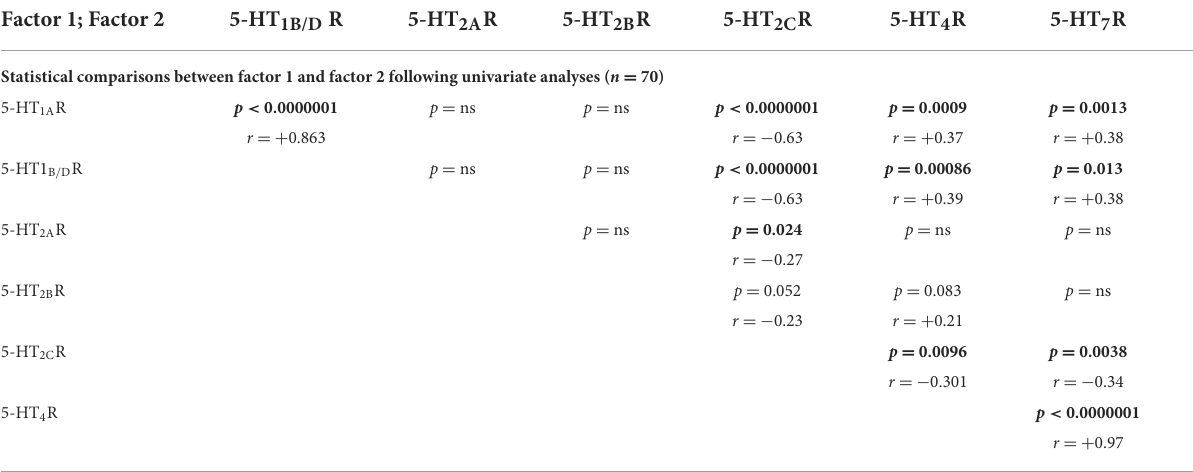
TABLE 2 Statistical correlations between the different 5-HTR receptors following univariate analysis. Factor 1; Factor 2 5-HT 1B/D R 5-HT 2A R 5-HT 2B R 5-HT 2C R Statisticalcomparisonsbetween factor 1 and factor 2 following univariate analyses ( n =